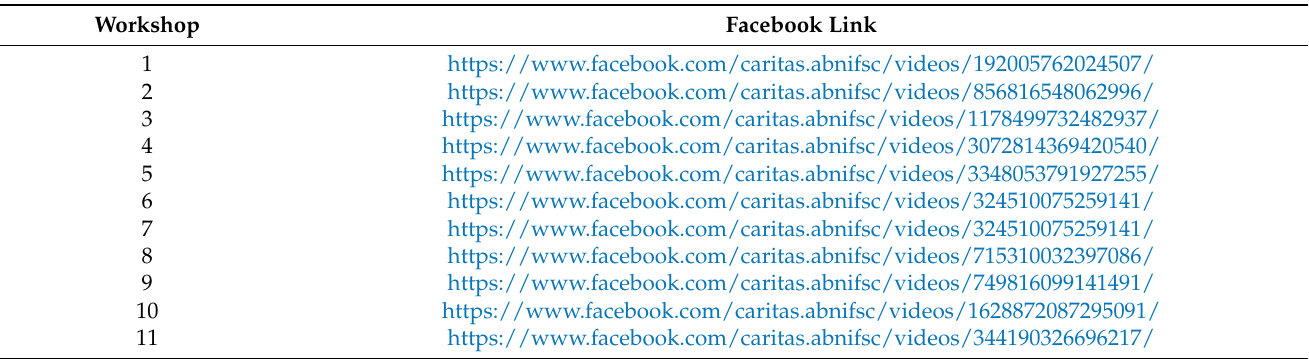
Table A1. Facebook links to all Caritas Aberdeen IFSC online Zentangle workshops during